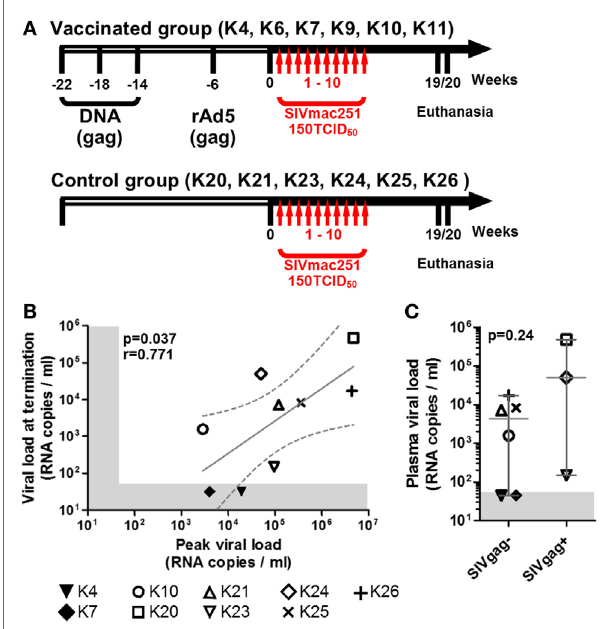
FigUre 1 | Macaques history, challenge schedule, and plasma viral loads . (a) Schematic representation of macaques treatment before (empty side of the arrow) and after inclusion in the study (solid black side of the arrow); vertical red arrows indicate weekly SIV challenges. (B) Scatter plot showing the direct correlation between peak of viremia (highest level of viremia measured throughout the study) and the viremia at study termination of all SIV + animals (non-parametric Spearman correlation); solid gray line shows the projected linear regression, and dotted lines show the 95% confidence interval. (c) Dot plot showing the difference in plasma viremia at termination between animals with detectable and undetectable SIVgag RNA in either midbrain or frontal lobe explants (SIVgag + and SIVgag − , respectively); statistical analysis was performed using a non-parametric Mann–Whitney test. In both plots, shaded areas indicate the range of undetectable viremia ( < 50 RNA